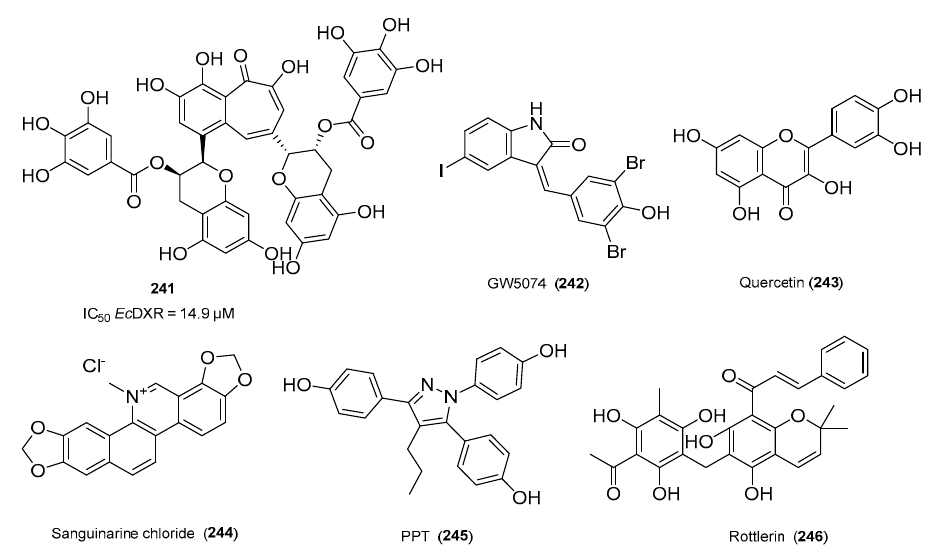
Figure 47. Structures of natural products ( 241 – 246 ) that potentially act as DXR inhibitors. Lead structures for the design of DXRi identified via HTS by Haymond et al.